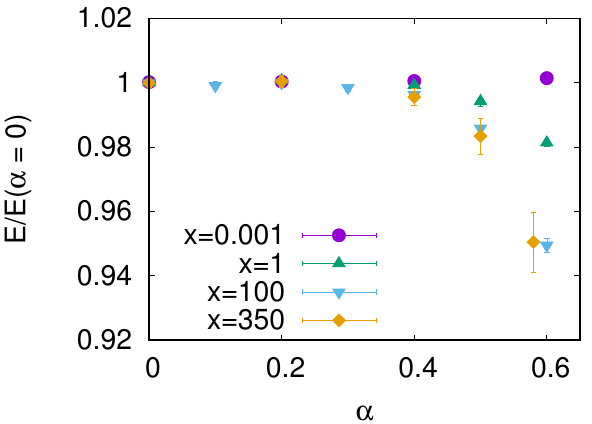
Figure 1: Ratio of the bulk DMC energy per particle, in units of the scattering length ( α ) to E ( α = 0, x ) , for different values of the gas parameter x . The maximum a 0 tilting angle used for x = 350 is α =